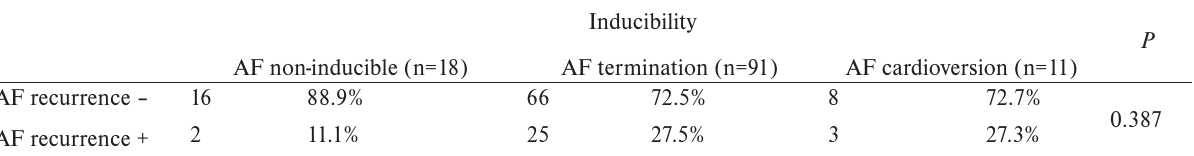
Table 2. AF Inducibility impact on arrhythmia recurrence 12 months after ablation.